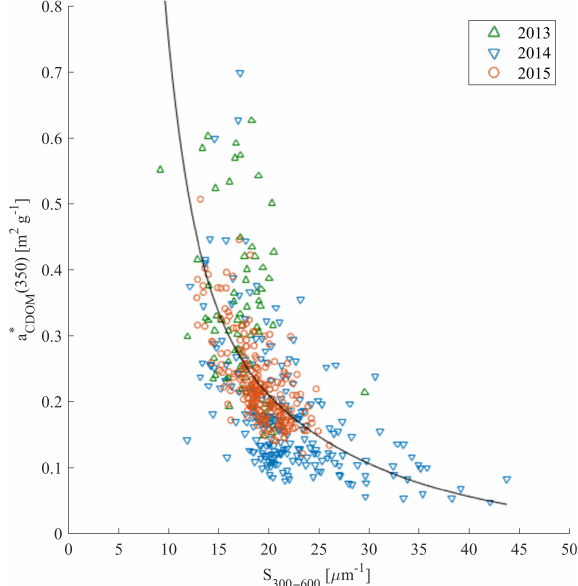
Figure 8. a ∗ (350) compared with S 300–600 in samples from CDOM 2013 (green triangles), 2014 (blue reversed triangles), and 2015 (red circles). Nonlinear fitting function between those parameters was adopted from Fichot and Benner (2012): y = e (b 1 − b 2 x) + e (b 3 − b 4 x) ; regression coefficients b 1 = 0.0027, b 2 = 73.31, b 3 = 1.29, and b 4 =− 91.39 were estimated with the MATLAB curve fitting tool- box, with determination coefficient R 2 = 0.38, n =